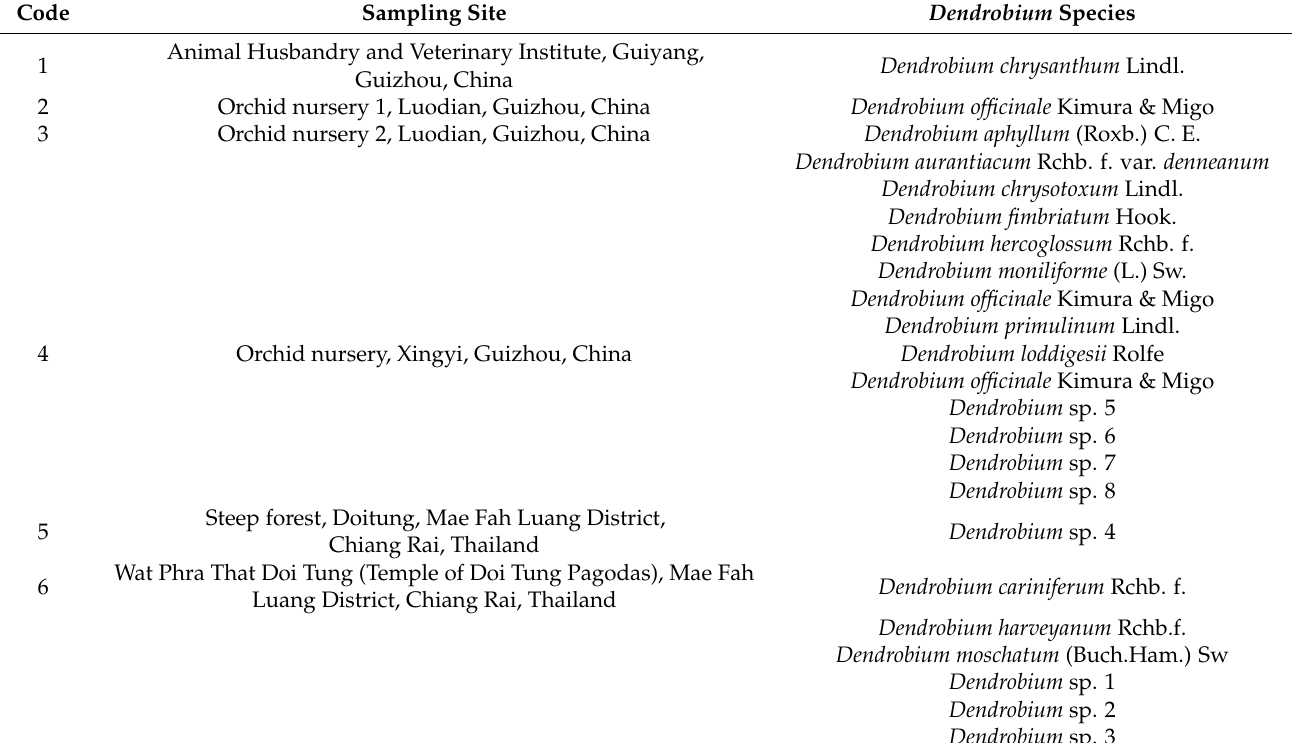
Table 1. Information on Dendrobium orchids from this